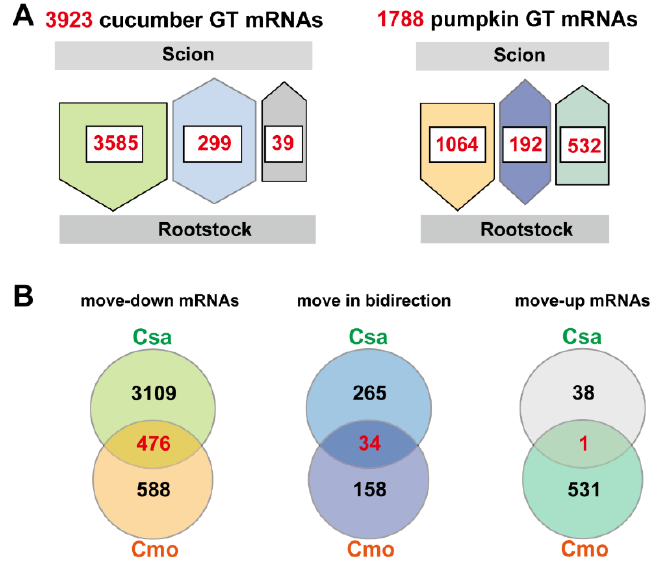
Figure 3. Long-distance movement of heterologous mRNAs between rootstock and scion. ( A ). Scheme with numbers and direction of mobile RNAs exchanged between heterologous tissues and exchanged between species. Nine transcript mobility classes were identified between shoot and root tissues and Csa and Cmo species. Three different possibilities of movement were found under each variable: (i) unidirectional rootstock-to-scion; (ii) unidirectional scion-to-rootstock; and (iii) bidirectional movement. GT, graft-transmissible. ( B ). Venn diagrams overlapping after homology analysis of cucumber and pumpkin in all directions. To compare Csa and Cmo homologous mRNAs, 1788 Cmo mRNAs matching 1781 homologous Csa protein-encoding mobile mRNAs by orthology analysis with best hits were used in the study. After filtering duplications, 1561 homologous Csa transcripts representing Cmo mobile transcripts were used for further analysis. Csa, Cucumis sativus ; Cmo, Cucurbita moschata .